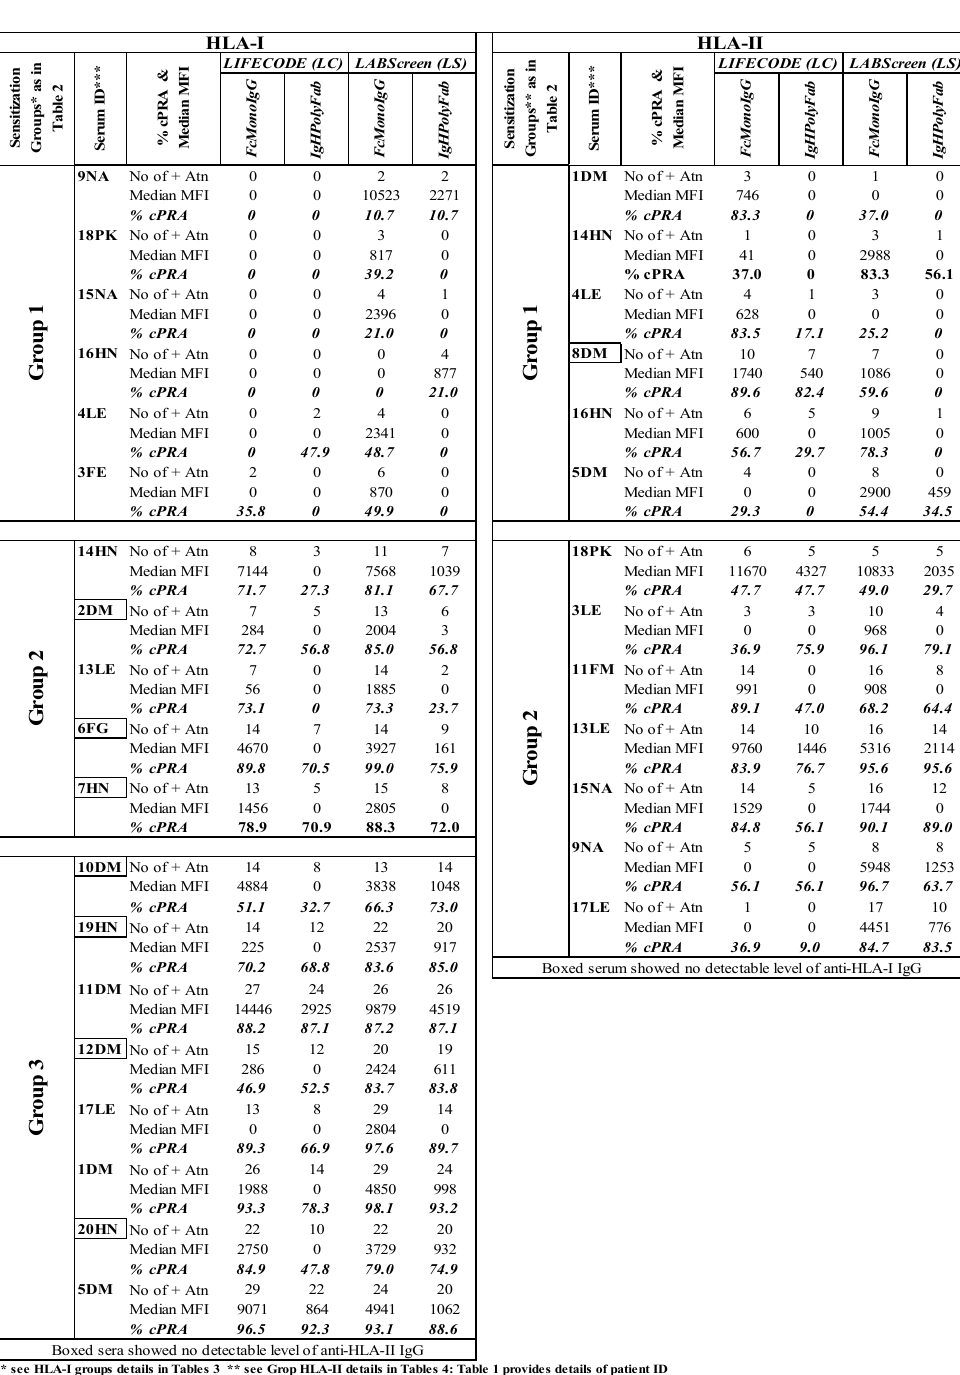
Figure 6. Estimations of cPRA values of ESRD patients for diseased donor organ selection differ between LABScreen and LIFECODES SABs and between the two different detection Abs FcMonoIgG and IgHPolyFab. The cPRA (panel-reactive antibodies) calculator on the following UNOS website was used: (https://optn.transplant.hrsa.gov/resources/allocation- calculators/cpra-calculator, accessed on 30 May